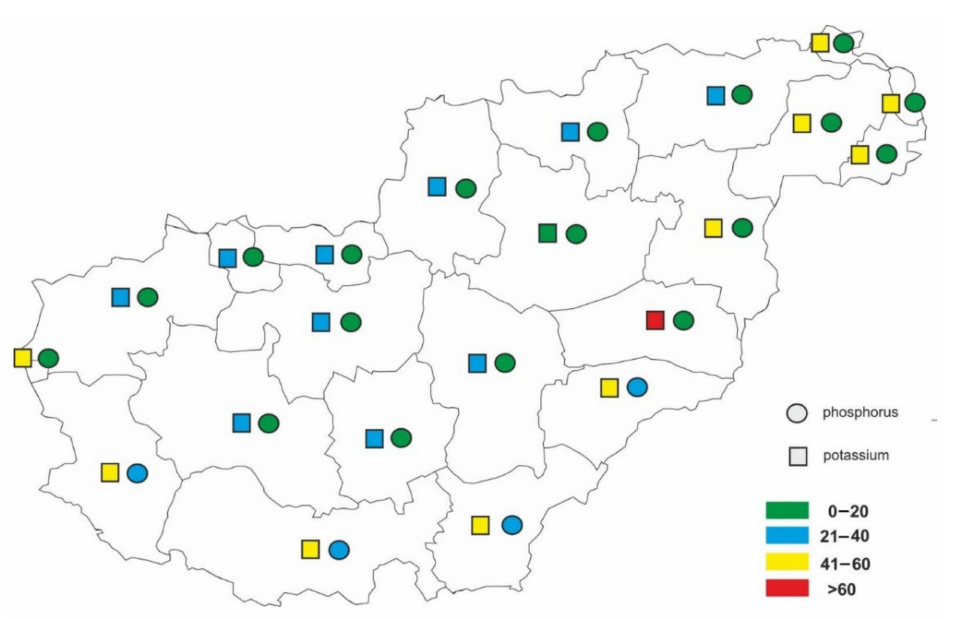
Figure 3. Buffers around the control points.